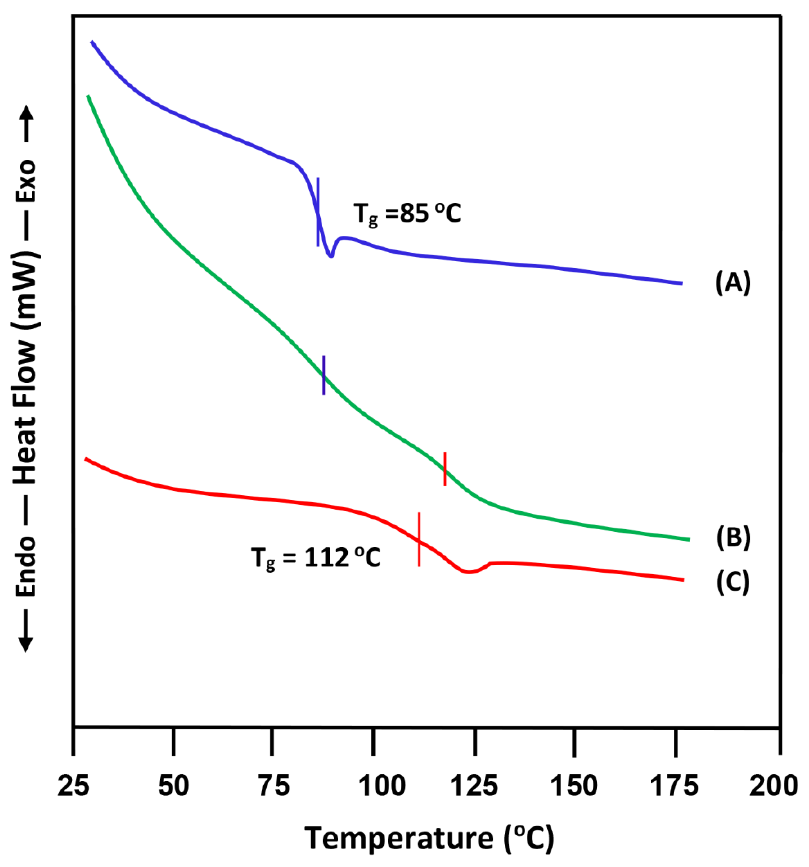
Figure 3. DSC thermograms of: (A) PVC; (B) PVC/PMMA-50 and (C) PMMA their pure components PVC and PMMA.